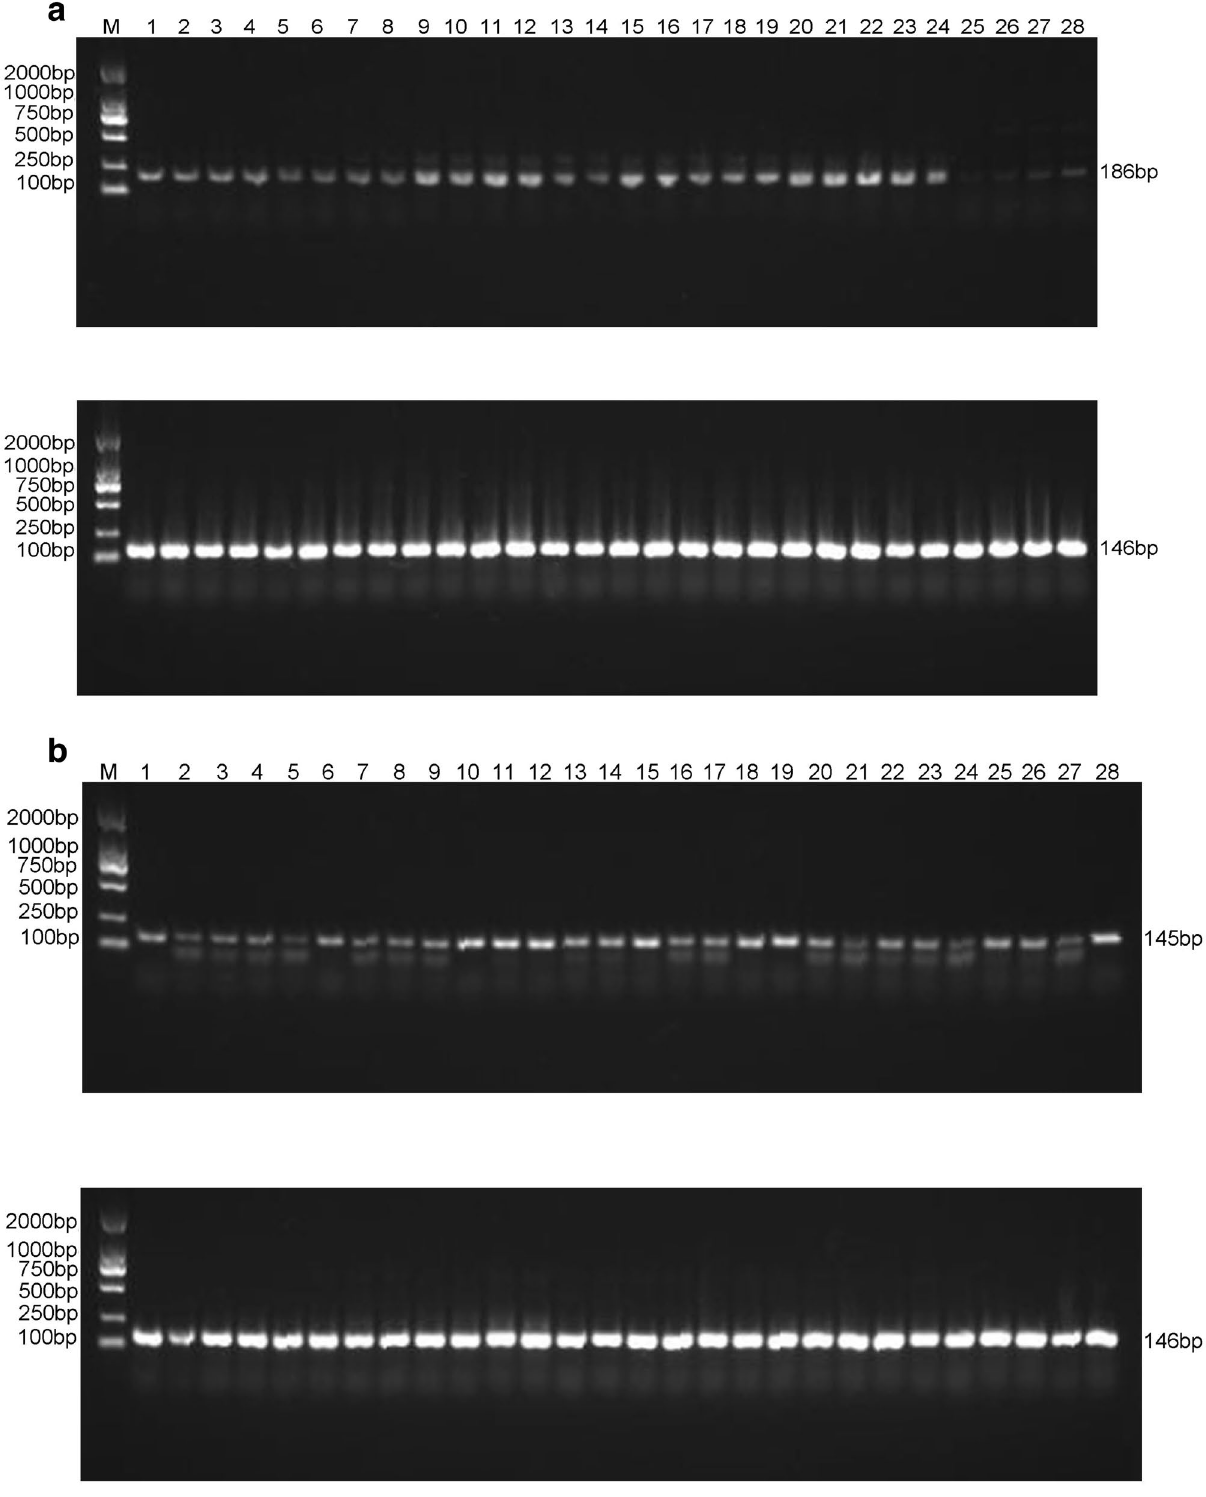
Figure 1. RT-PCR of FAD3C-1 , ACC , GAT expression in seven developmental periods. ( a ) FAD3C-1 , ( b ) ACC , ( c ) GAT . below the target gene is the internal control gene Lectin . Lane numbers indicate the soybean developmental stage as follows: lanes 1–4, 20 d after flowering, 5–8, 30 d after flowering, 9–12, 40 d after flowering, 13–16, 50 d after flowering, 17–20, 60 d after flowering, 21–24, 70 d after flowering, 25–28, 80 d after